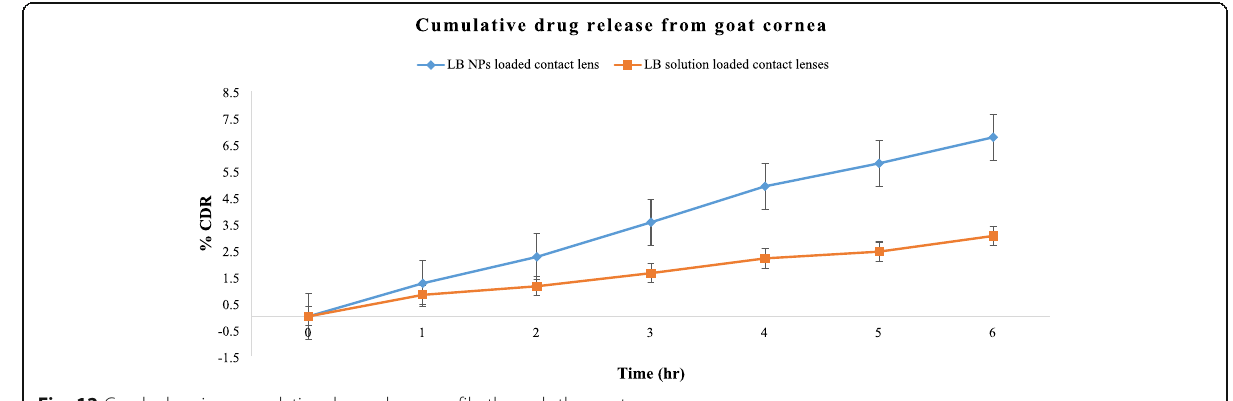
Fig. 12 Graph showing cumulative drug release profile through the goat